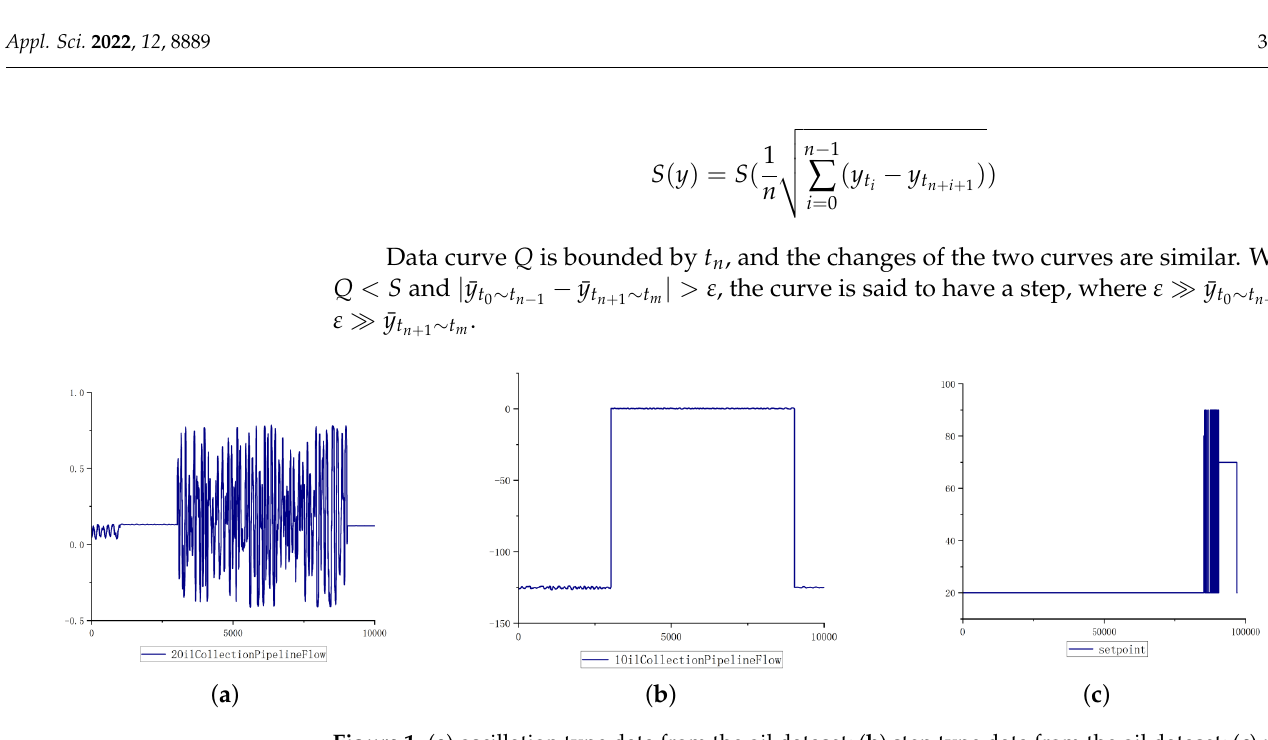
Figure 1. ( a ) oscillation type data from the oil dataset; ( b ) step type data from the oil dataset; ( c ) pulse type data from the gas